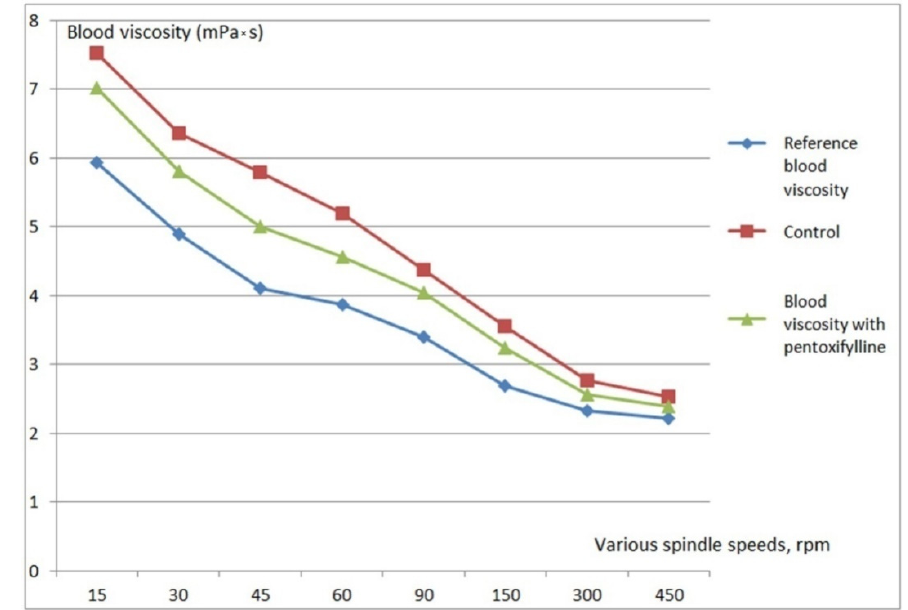
Figure 5. The hemorheological activity of pentoxifylline.